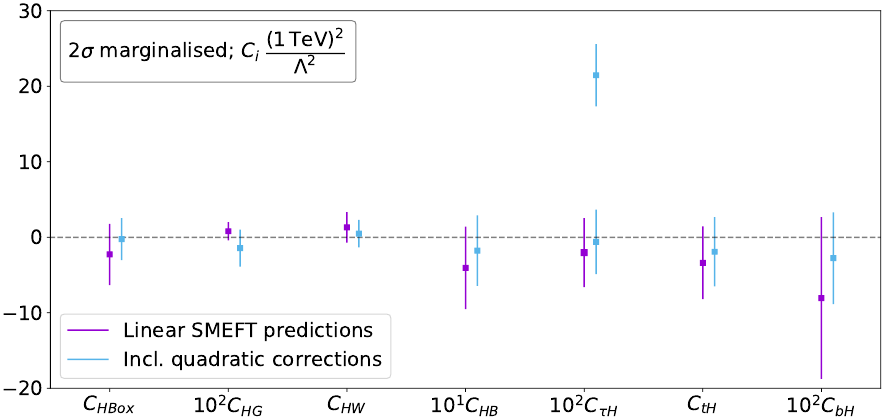
Figure 21 . Marginalised 95 % credible intervals for each of the indicated operator coefficients resulting from a fit to Higgs signal strength data using nested sampling. We compare the effects of including quadratic contributions from dimension-6 operators (blue) to the case of linearised SMEFT predictions